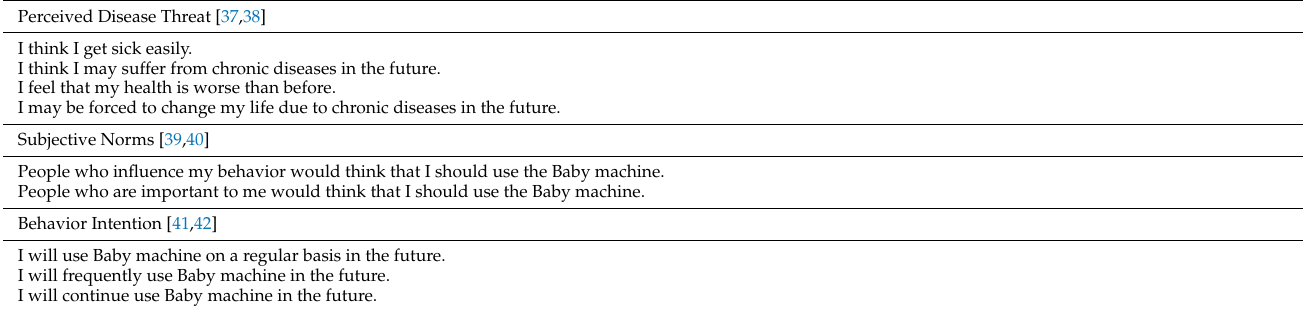
Table A2. Items of the questionnaire for participants of the measurement